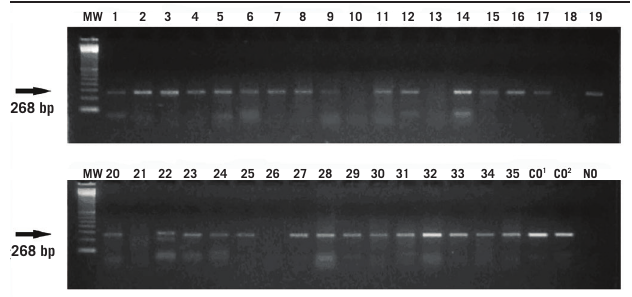
FigurE 1 − Electrophoresis in 2% agarose gel stained with ethidium bromide. β -globin DNA amplification (268 bp) from the 35 floor of mouth squamous cell carcinoma samples DNA: deoxyribonucleic acid; MW: 100 bp DNA ladder; CO 1 : human genomic DNA; CO 2 : condyloma DNA; NO: no DNA control; MW: molecular weight.